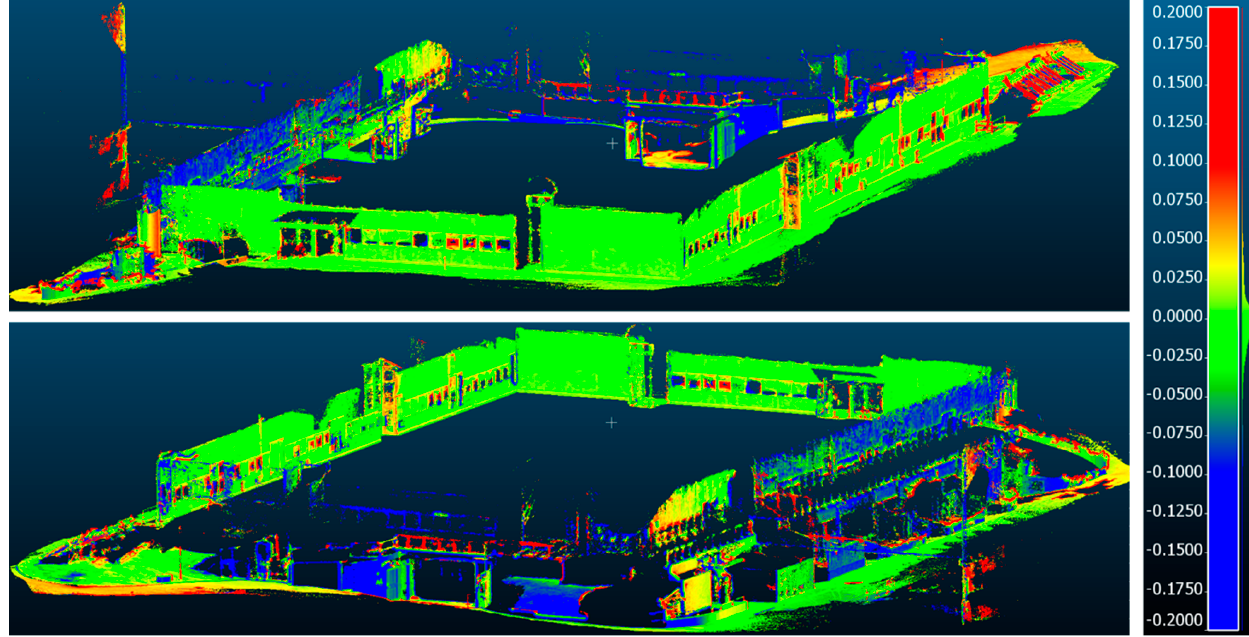
Figure 11. Dense point cloud obtained from the selected images with the standard photogrammetric pipeline (Case 2.) and color-coded signed Euclidean distances [m] with respect to the ground truth. The gaps in the lower left area correspond to zone #2 in Figure 10a.